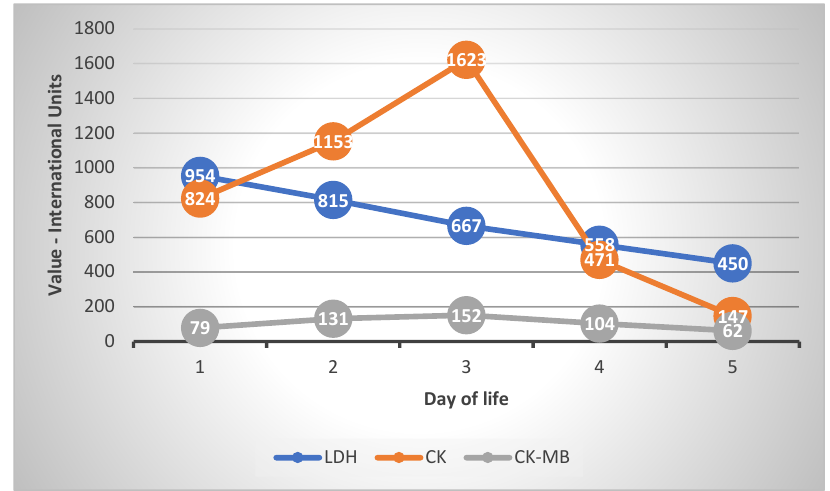
Figure 4. Boold markers of